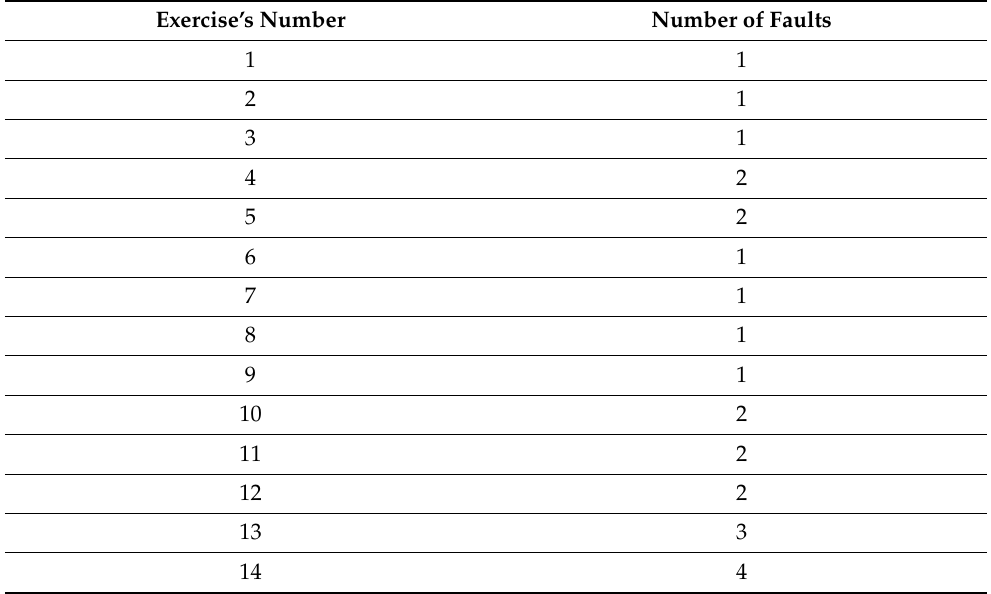
Table 1. Number of faults to identify in each question. Exercise’s